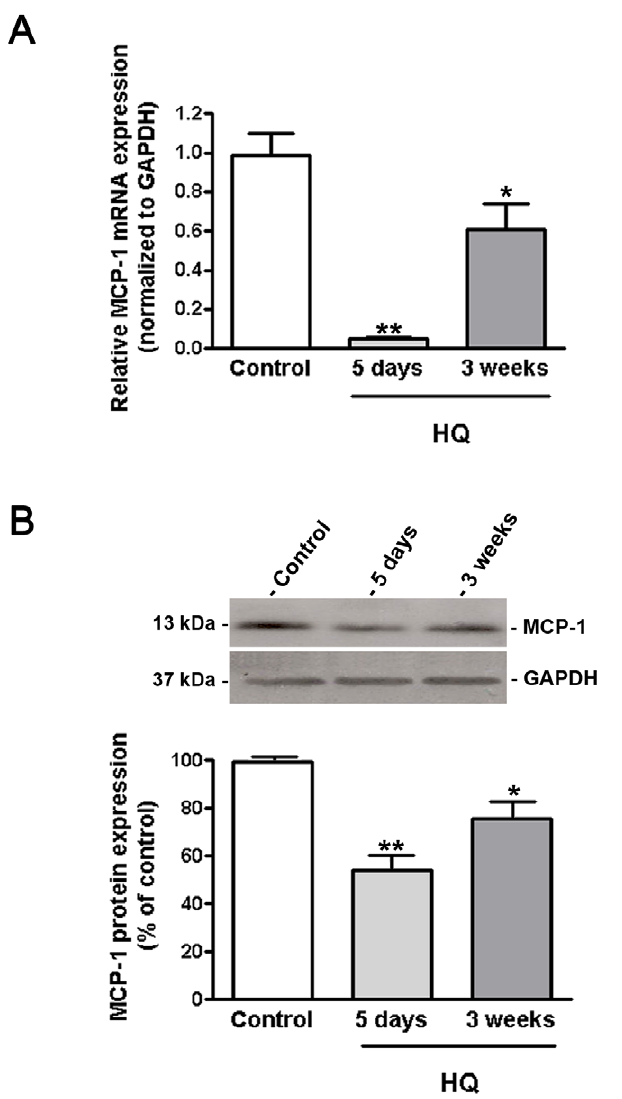
Figure 3. MCP-1 expression is decreased in RPE/choroids from mice exposed to HQ. ( A ) MCP-1 mRNA expression was downregu- lated in response to HQ-induced oxidative injury. Total RNA was extracted from microdissected RPE/choroid complexes after 5 days and 3 weeks of exposure to HQ in drinking water (0.8%). MCP-1 mRNA expression was measured by real-time PCR. GAPDH was used as internal control (n=5 eyes per group). ( B ) MCP-1 protein expression was downregulated in response to HQ-induced oxidative injury. Total protein was extracted from microdissected RPE/choroid complexes after 5 days and 3 weeks of exposure to HQ in drinking water (0.8%). Equivalent amounts of protein from 5 eyes per group were pooled for each lane. MCP-1 protein expression was evaluated by Western blot and normalized to GAPDH. Top: representative Western blot gel. The numbers to the left are molecular weights in kilodaltons (KDa). Bottom : average densitometry results. Data are expressed as percentage of control and are means 6 SE. * is p , 0.05 and **p , 0.01 versus control.